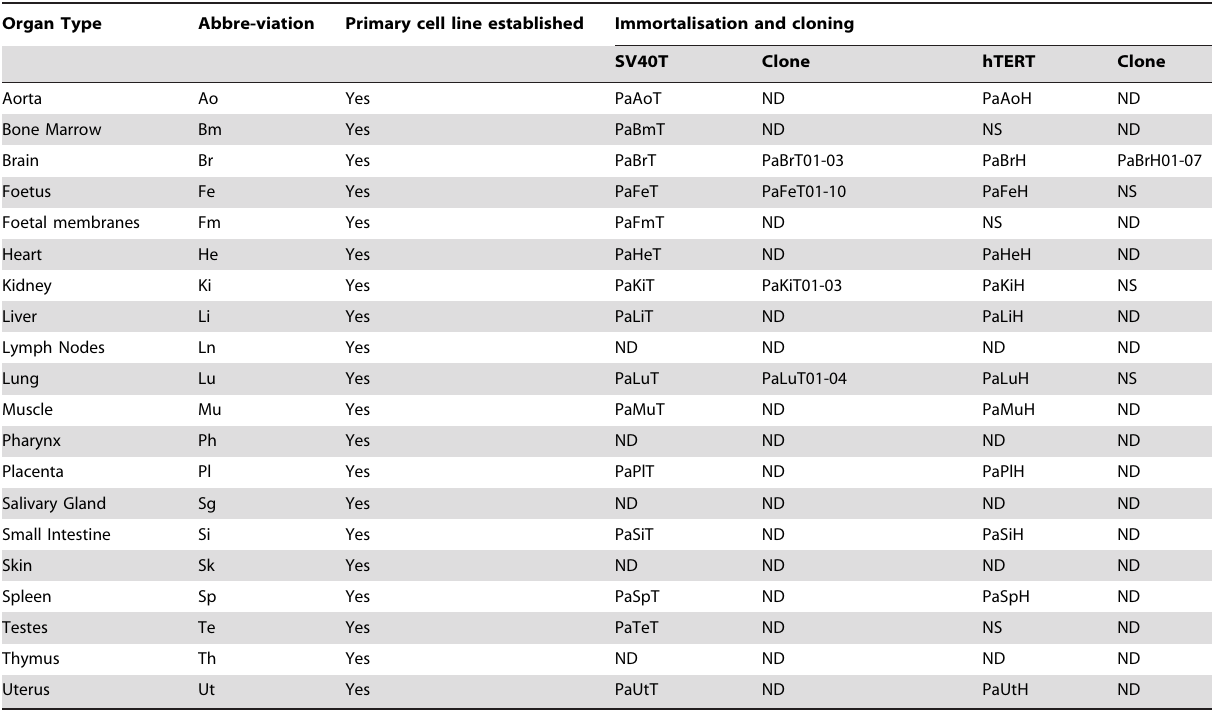
*Abbreviations: ND, not done; NS, not successful. Cell line nomenclature: first two letters indicated species (Pa = Pteropus alecto ); second two letters represent the abbreviation of the original organ type from which the cell line was derived (e.g., Ki = kidney); the fifth letter indicates methods of immortalisation (T = SV40T and H = hTERT); the clone number is provided at the end in two-digit format (e.g., PaKiT01 = clone # 1 of the P. alecto kidney cells immortalised using the SV40T approach).